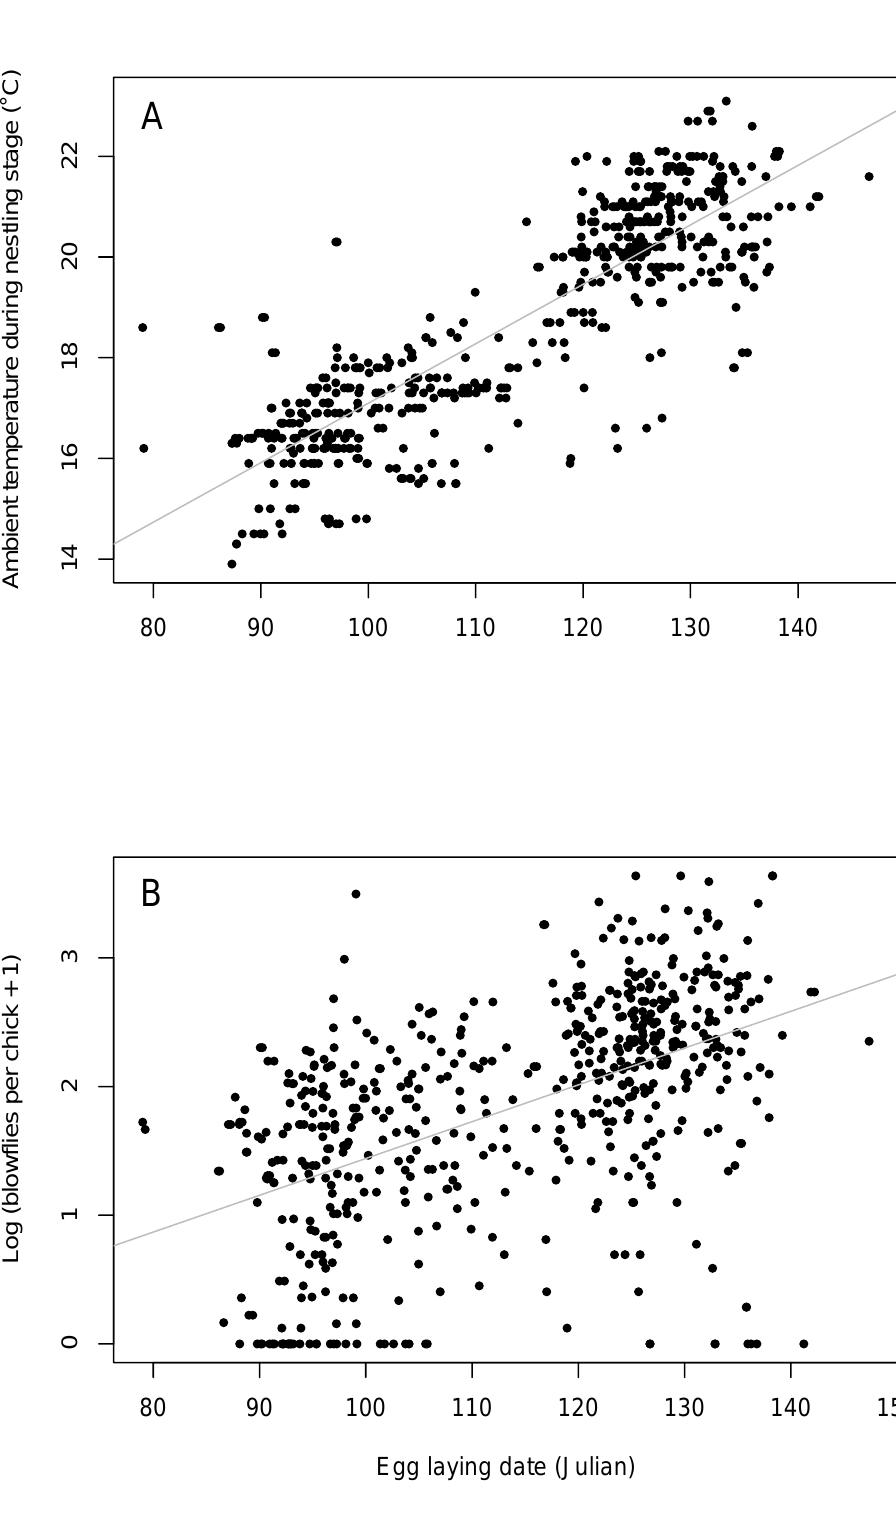
Figure S2. Both average ambient temperature (A) and parasite load (B) during the nestling stage increase with egg-laying